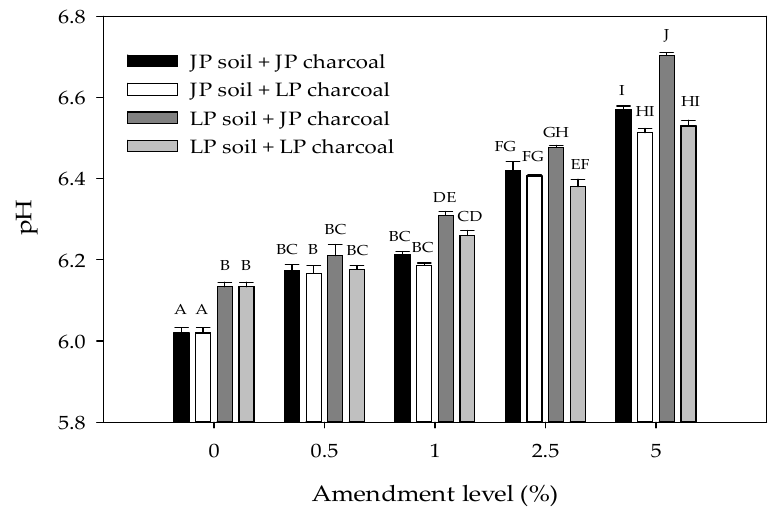
Figure 1. Soil pH as a function of charcoal type and amendment level in Jeffrey pine (JP) and lodgepole pine (LP) soils. Error bars represent standard error of the mean pH ( n = 3). Different letters indicate significant differences ( p < 0.05) across soil types, charcoal types, and amendment levels.